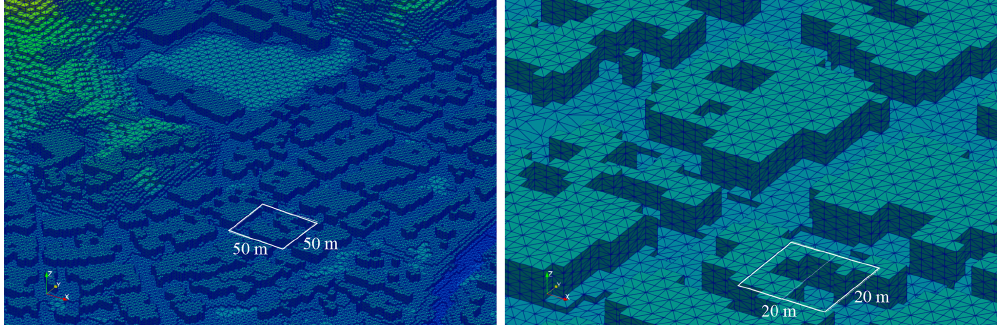
Figure 7. Bird’s eye view of FE meshes at two different rates of magnification.